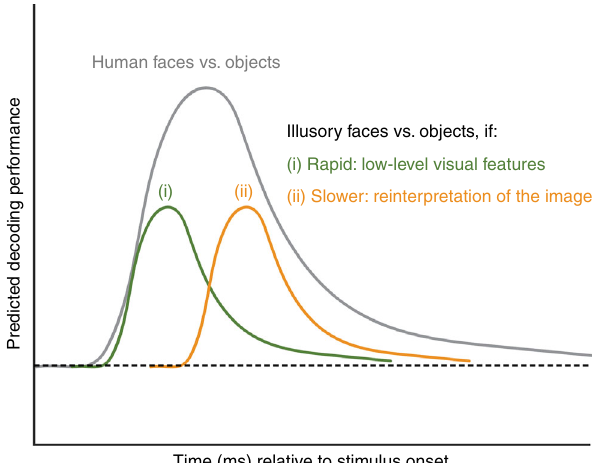
Fig. 4 Schematic diagram showing predicted results for MEG cross- decoding of illusory faces vs. objects based on two possible accounts: (i) rapid processing based on low-level visual features (green line), or (ii), slower reinterpretation of the image (orange line). Relative to decoding human faces vs. objects (gray line), performance is expected to be reduced because illusory face images share many more visual features with the matched object images than they do with human face images, thus brain activation patterns for these categories are expected to be less separable. See Fig. 5a for the empirical